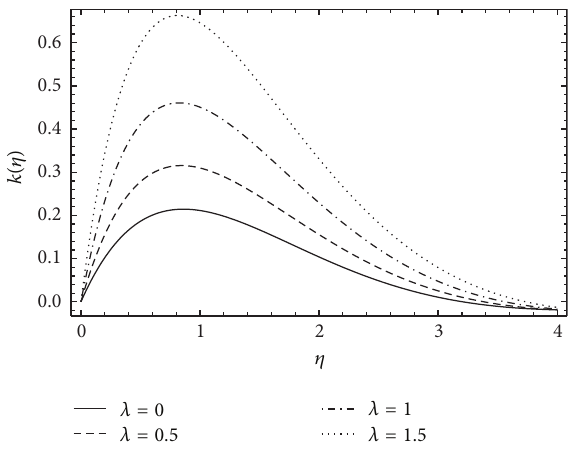
Figure 9: The influence of the couple stress parameter 𝜆 on 𝑘(𝜂) for 𝛼 = 1 , ℏ = −0.1 , and 𝜆 = 0 (Newtonian case).